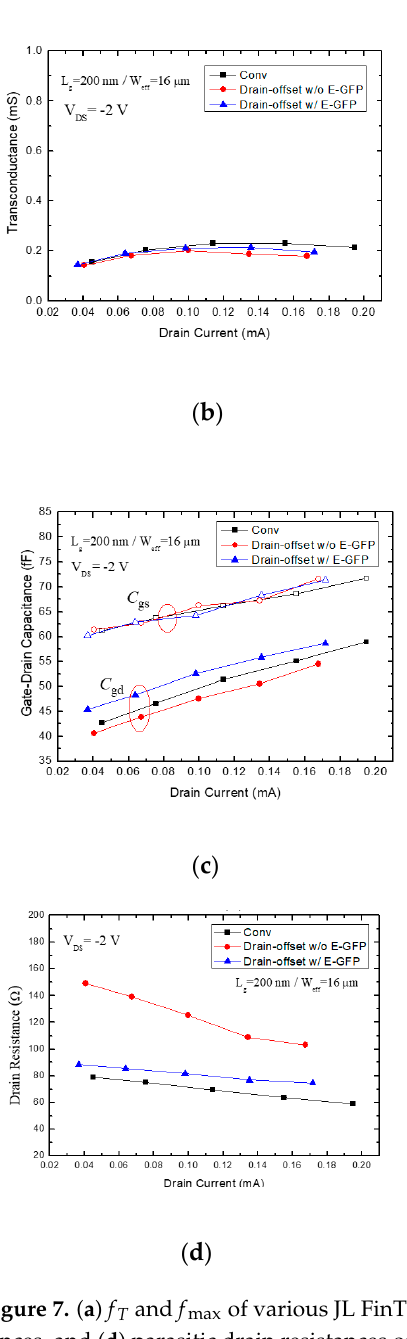
Figure 7. ( a ) f T and f max of various JL FinTFTs . Extracted ( b ) transconductance, ( c ) parasitic capaci- tances, and ( d ) parasitic drain resistances of various JL FinTFTs .